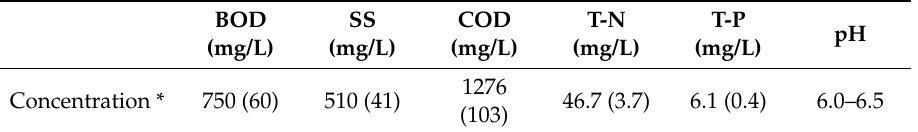
Table 2. Composition of synthetic disposer wastewater used in this study.